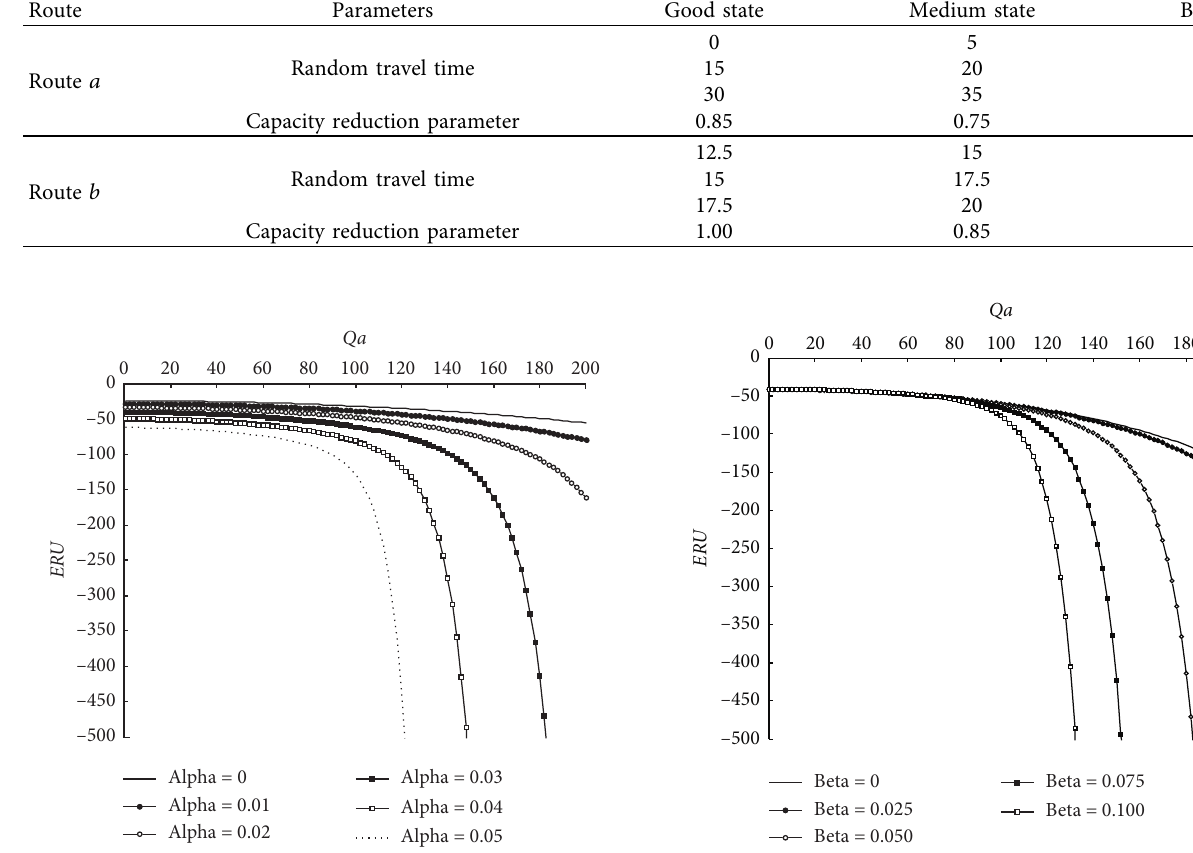
Figure 4: Expected regret-based utility of route a based on different risk aversion scenarios.